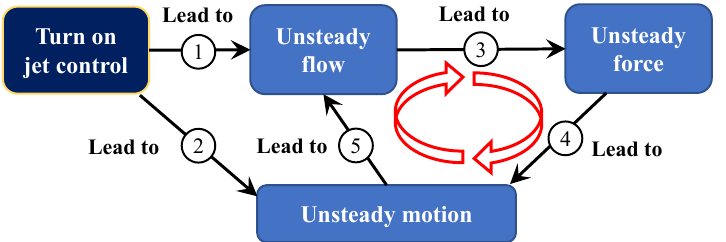
Figure 1. The relationship between the jet, flow field, aerodynamic force, and motion of an actual air vehicle when jet control is activated.